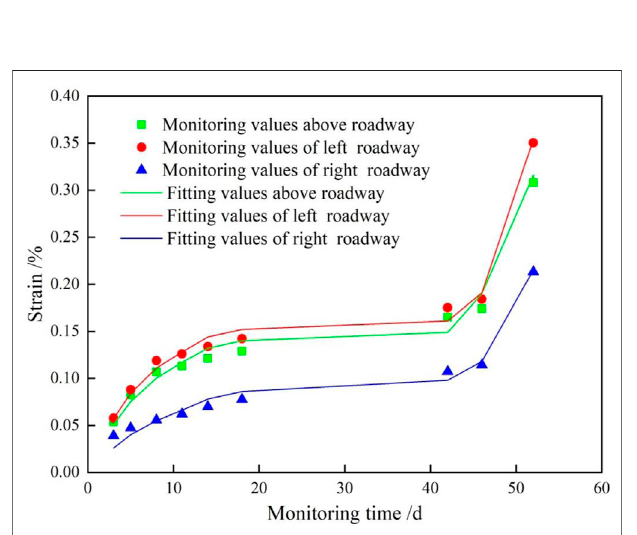
FIGURE 6 | Relationship between numerical monitoring data and theoretical analysis in dry state.